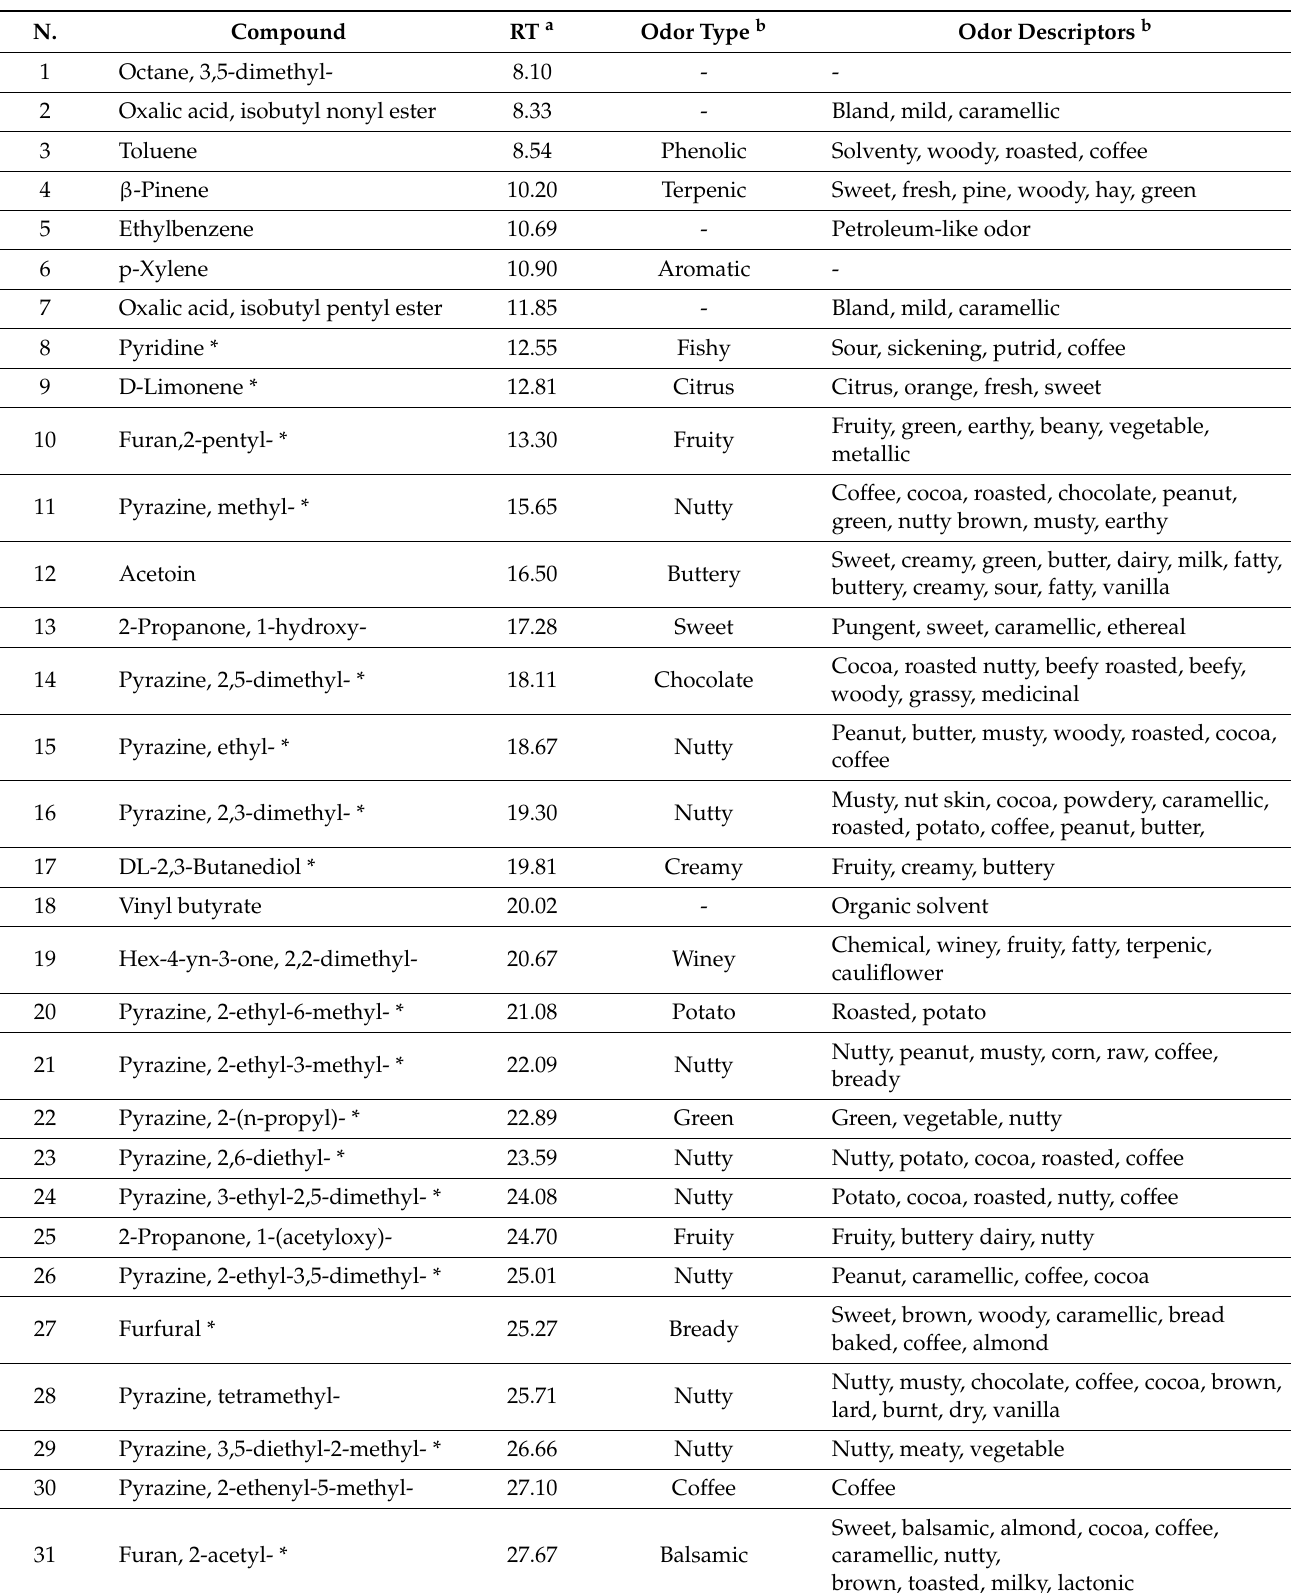
Table 1. Volatile compounds found in the headspace of roasted coffee